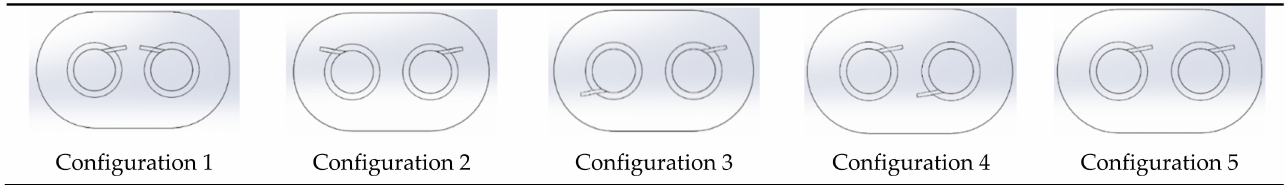
Figure 7. Inlet configurations of dual-vortex